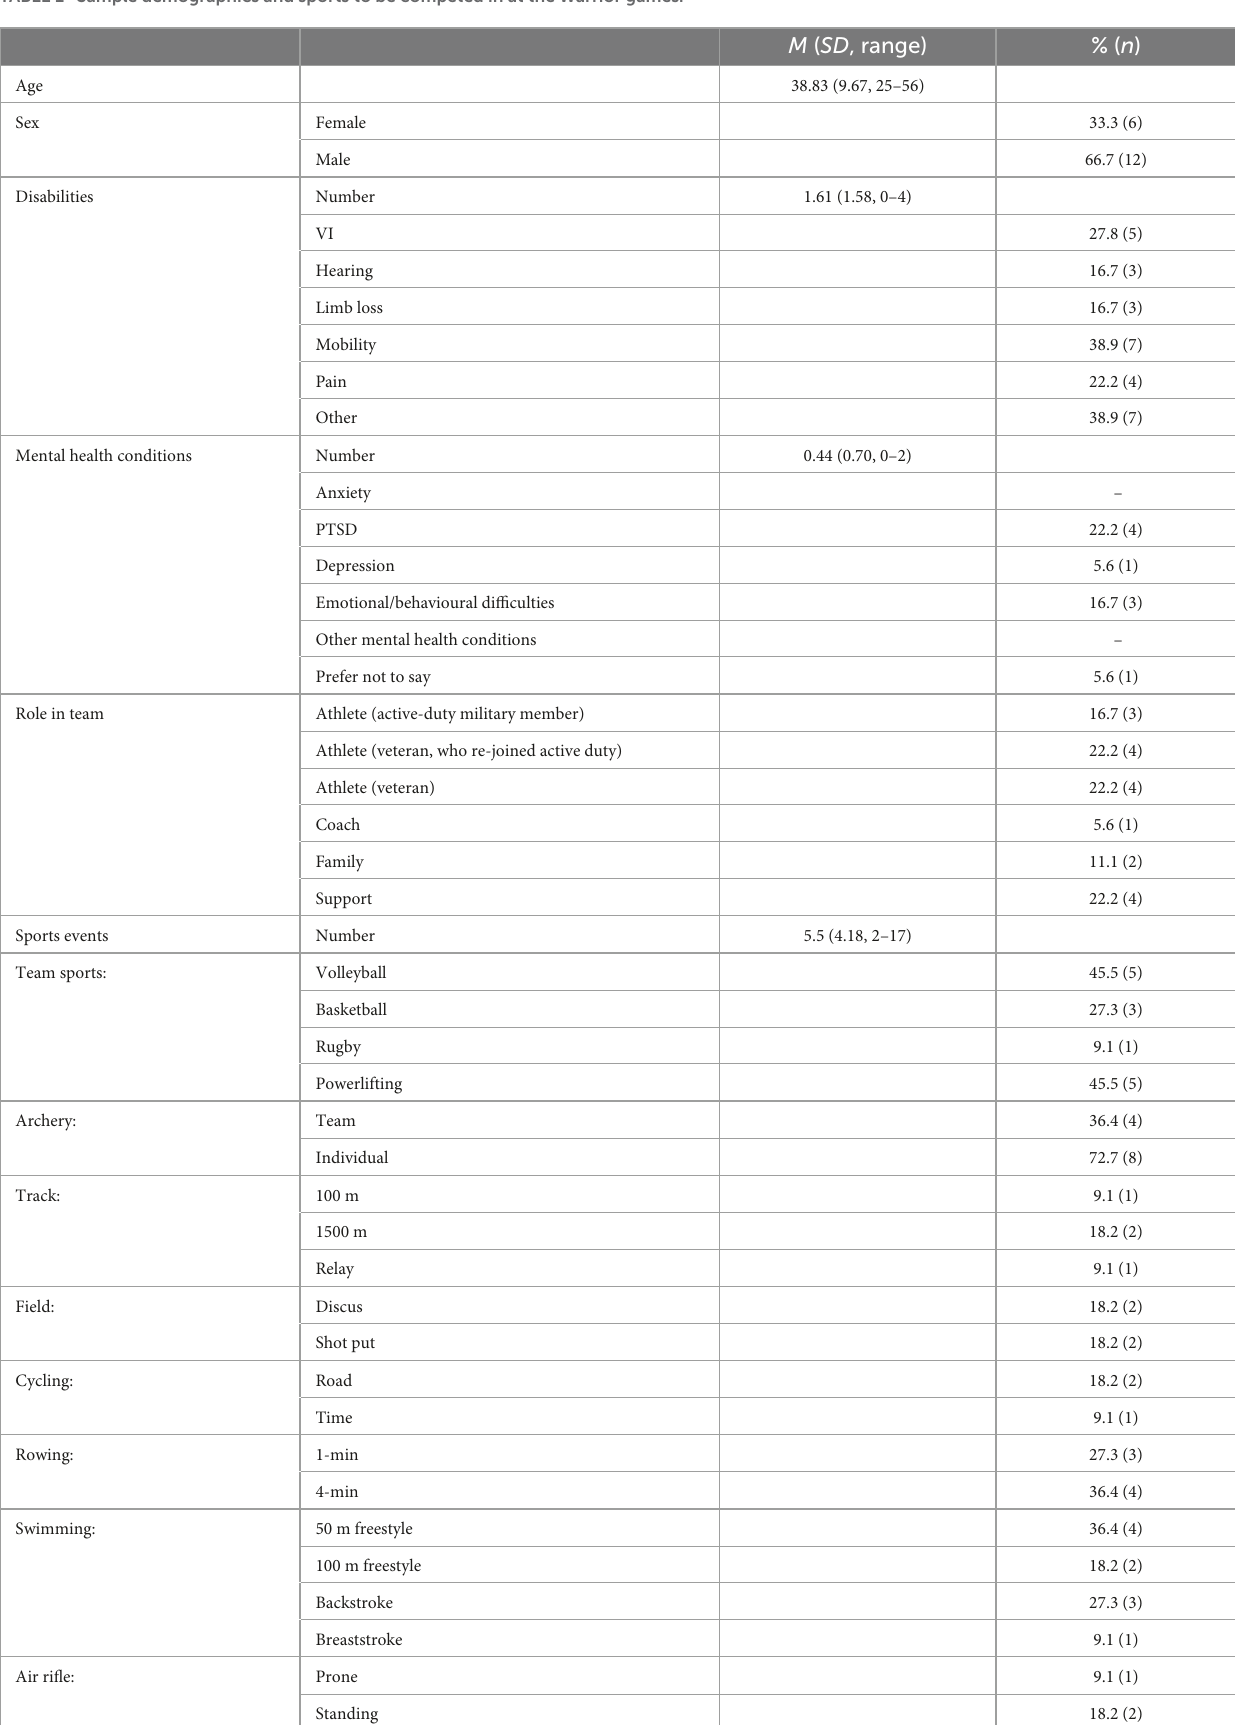
TABLE 1 Sample demographics and sports to be competed in at the Warrior games.